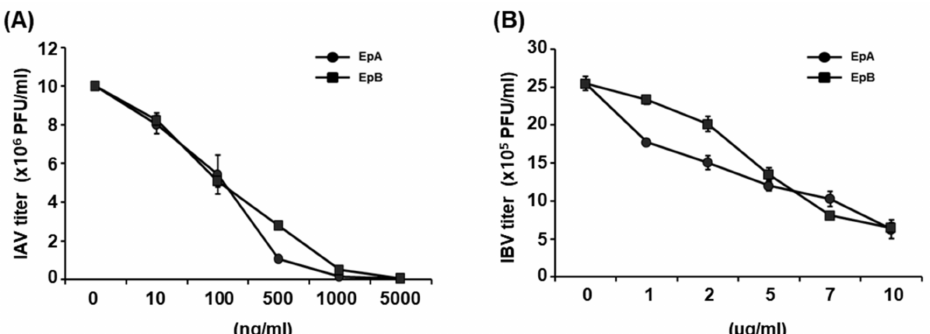
Figure 4. Inhibition of influenza virus infection by ethyl pheophorbides a and b. Serially diluted ( A ) IAV or ( B ) IBV were pre-treated with different concentrations of ethyl pheophorbide a (EpA) or b (EpB). After incubation at room temperature for 1 h, MDCK cells were infected with the mixture containing IAV and IBV at MOI of 0.01 and 0.001, respectively. At 1 h after infection, the mixture was removed and viral titers (PFU/mL) were determined 48 h after infection using a plaque assay. All experiments were performed in